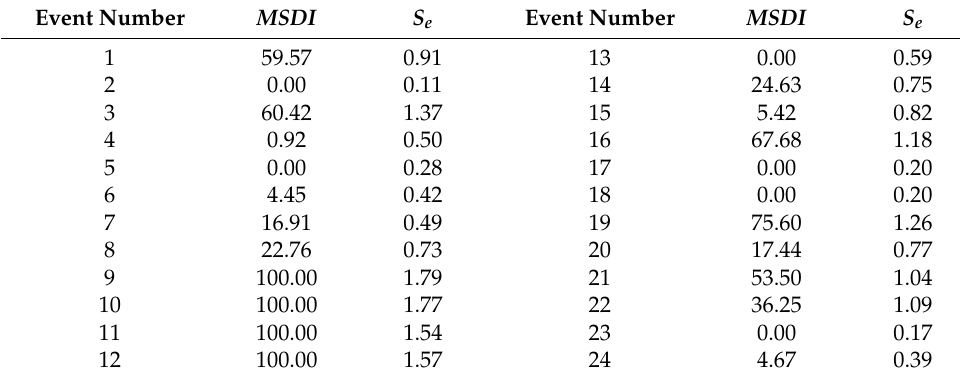
Table 5. Evaluation results based on MSDI and S e .